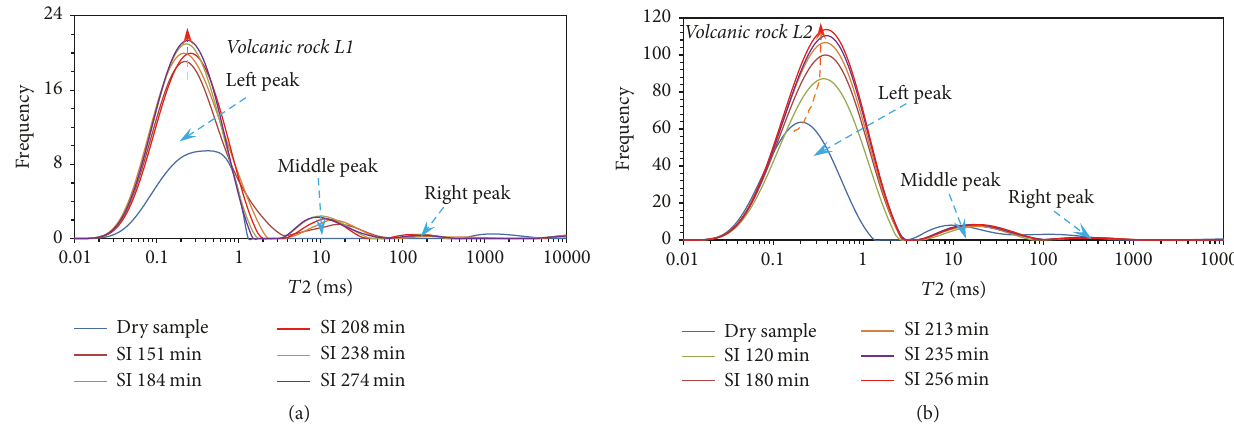
Figure 4: The T2 spectra of samples: L1 and L2 for various spontaneous imbibition times (SI is the acronym spontaneous imbibition).